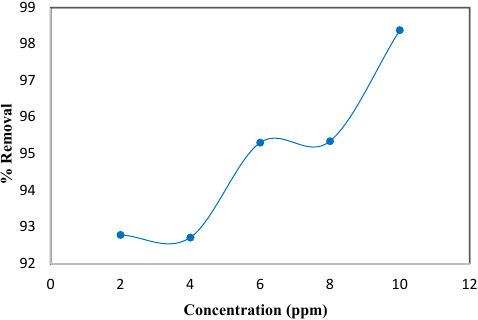
Fig. 3. Effect of initial metal ion concentration for the percentage removal of iron (III) by CuO